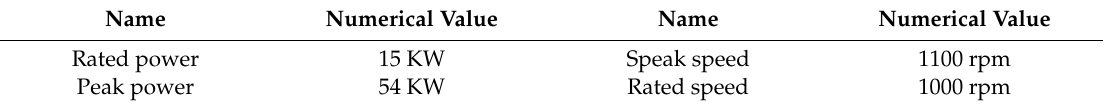
Table 2. Technical parameters of IWM.